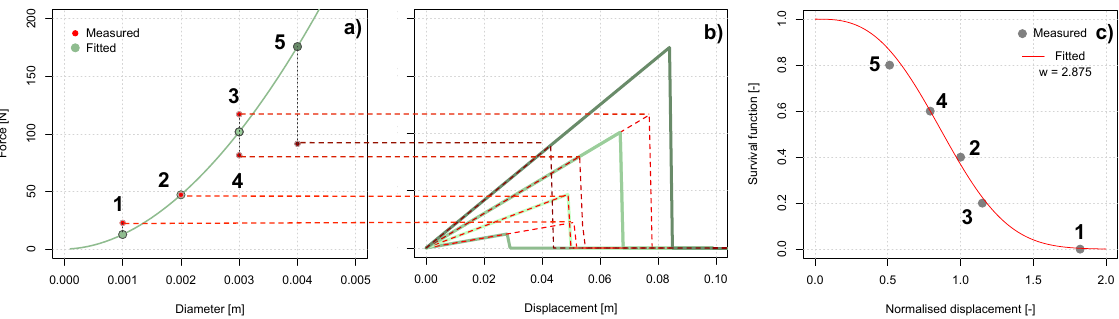
Fig. 1. The plots show key steps for the calibration of the Weibull exponent of the normalized survival function. The root diameter – pullout force plot (a) shows measured (red dots) and fitted values (green dots) of the five roots. (b) shows the calculated force-displacement of each single root in the bundle considering either the measured (red dashed lines) or the fitted (green lines) values of maximum pullout force. (c) shows the data (gray dots) and best fit (solid line) of the distribution of the survival probability as function of the normalized